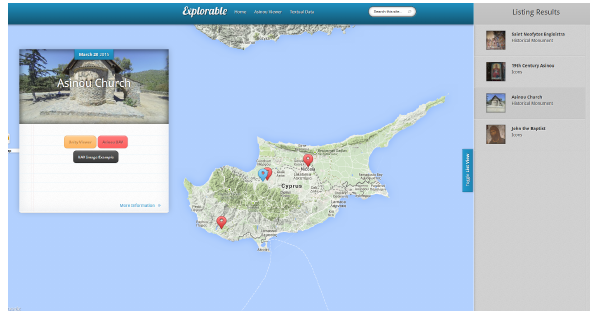
Figure 9: Homepage with Viewer Options